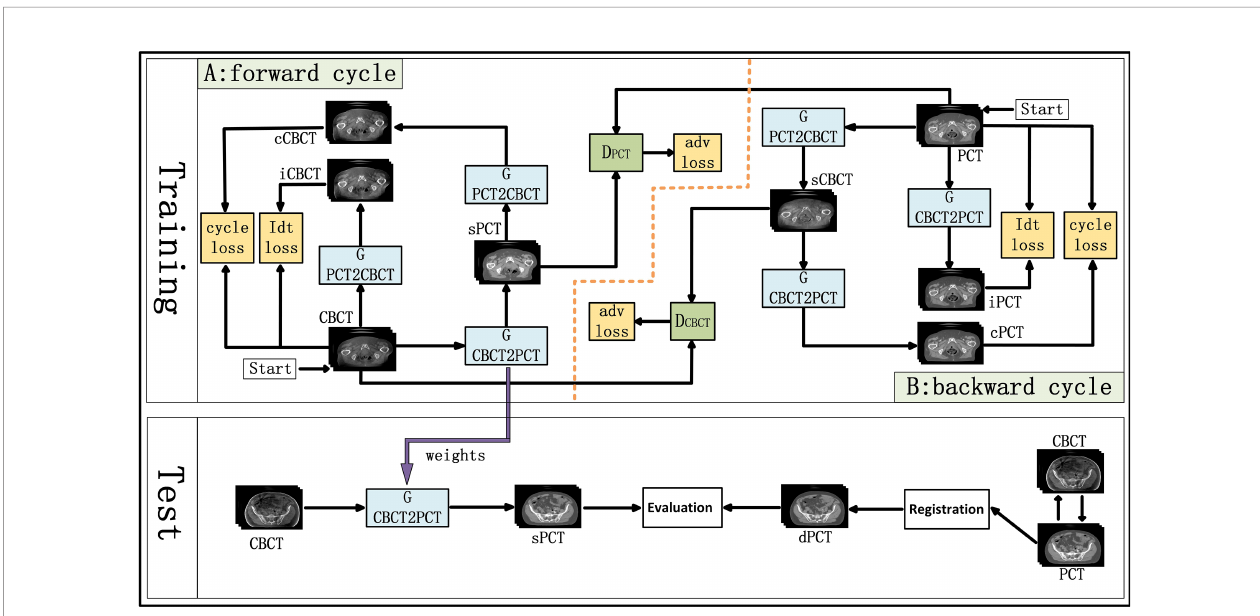
FIGURE 1 | Schematic fl ow chart of the image synthesis using CycleGAN. The top area represents the training stage, and the bottom area represents the test stage. In the training phase, cone-beam computed tomography (CBCT) and plan CT (PCT) images are input into the network. The training network generates fake synthetic PCT (sPCT), cycle CBCT (cCBCT), identity CBCT (iCBCT) from CBCT, and fake synthetic CBCT (sCBCT), cycle PCT (cPCT), identity PCT (iPCT) from PCT. At the same time, the discriminator is trained to learn the relationship between sPCT and PCT, forcing the generator to produce sPCT closer to the PCT. SPCT is the generated fake image, the closer it is to dPCT, the better the quality of the generated image is; iCBCT is an image generated by CBCT input into G PCTtoCBCT generator to avoid the model migration of too many texture features; cCBCT is an image generated by sPCT input into G PCTtoCBCT generator, with the purpose of one-to-one mapping of the model to ensure the consistency of the anatomical structure of sPCT and CBCT. In the test phase, CBCT images were input into the trained CycleGAN network to quickly generate sPCT images. The sPCT images are compared with the registered dPCT